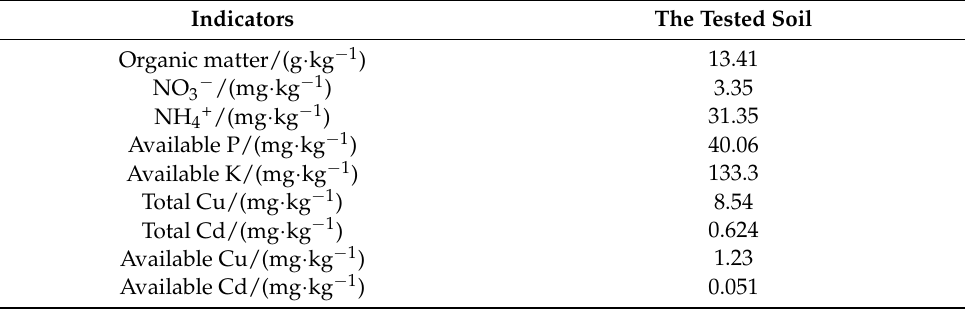
Table 1. Physical and chemical properties of the tested